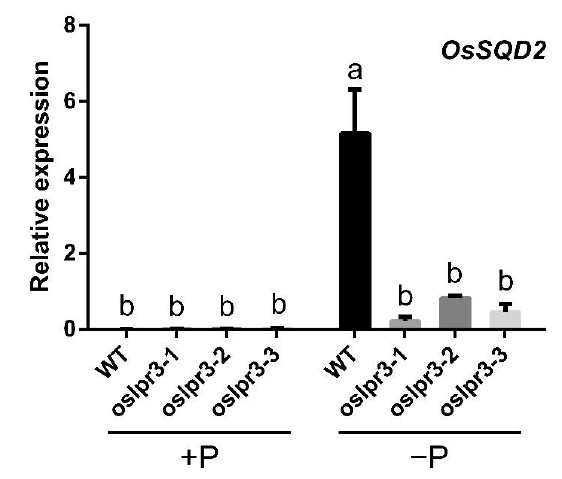
Figure 8. Expressions of Pi-starvation-induced genes in WT and oslpr3 mutants. Seedlings (10-d-old) of WT and oslpr3 lines were grown hydroponically under +P (200 μM Pi ) and −P (5 μM Pi) conditions for 10 d. Relative transcript levels of OsIPS1 , OsPAP10a , and OsSQD2 in the roots were determined and compared with those of OsActin via qPCR. Values are means ± SE ( n = 3). Different letters above the bars indicate significant differences ( p < 0.05, one-way